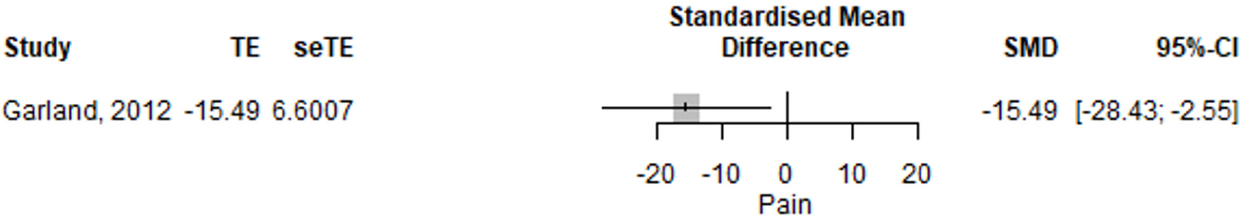
Figure 7. Irritable bowel syndrome pain scale—standardized mean difference comparison between mindfulness intervention and control. SMD, standardized mean difference; TE, treatment effect as SMD; seTE, standard error of the treatment effect; CI, confidence interval [15].